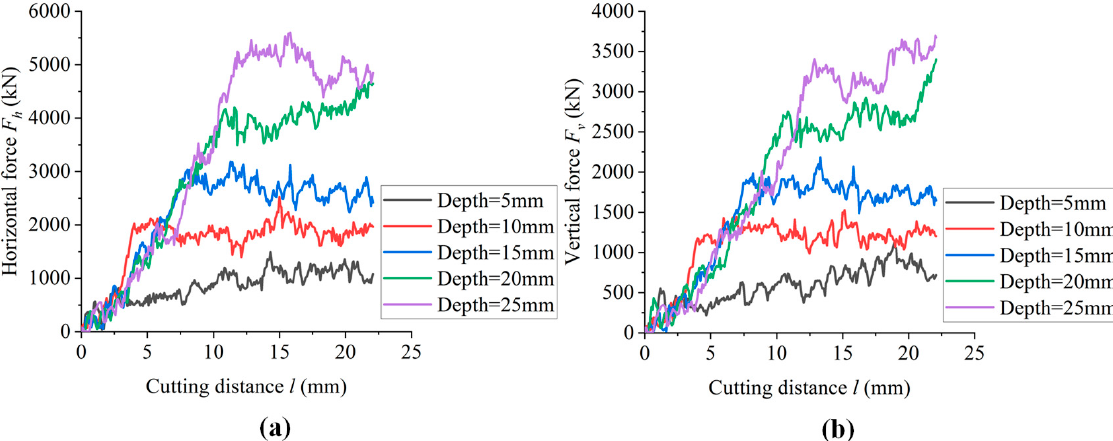
Figure 15. Cutting force vs. cutting distance curves at different cutting depths. ( a ) Horizontal component vs. cutting distance; ( b ) vertical component vs. cutting distance.